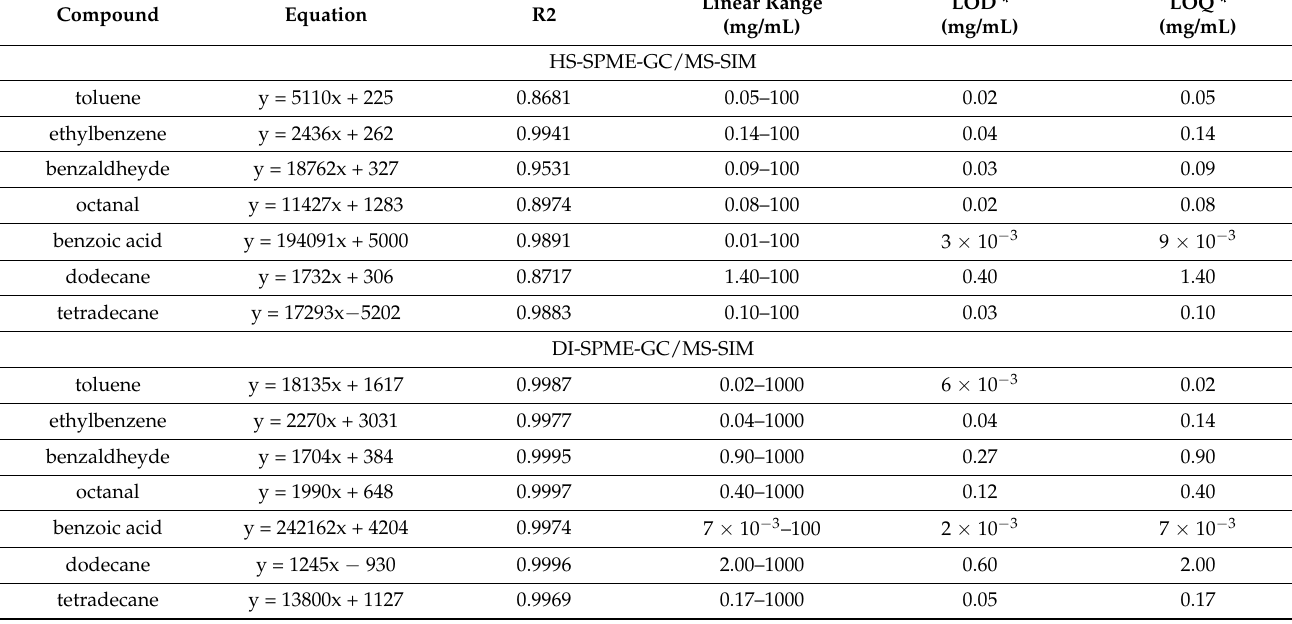
Table 2. Linear ranges, equations of the calibration curves, LOD and LOQ calculated for the